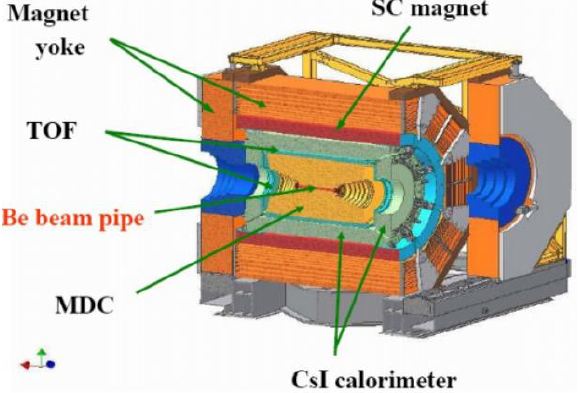
Fig. 1. The view of BESIII